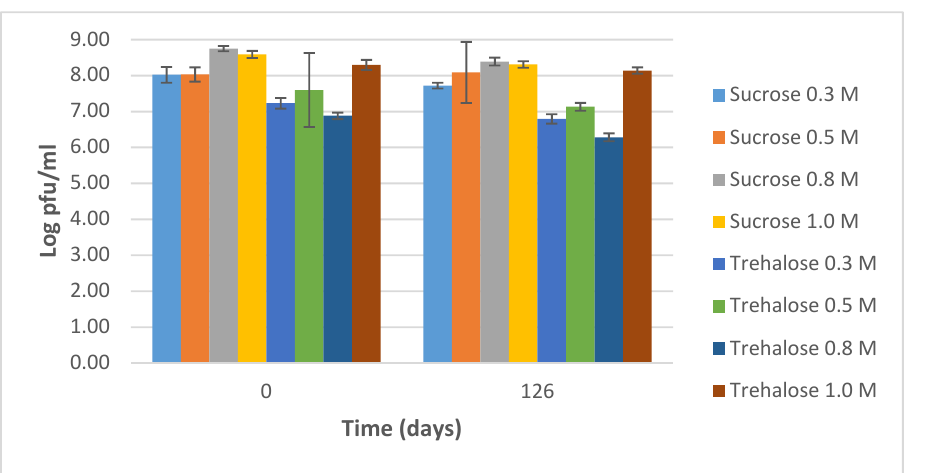
Figure 3. Stability of the infectivity of phage ISP, lyophilized at 9 log pfu/mL in two different stabilizers (sucrose and trehalose) at four different concentrations (0.3, 0.5, 0.8 and 1.0 M), after resuspension in saline and storage at 4 °C for 126 days. The results are the mean values of three titrations. Standard deviations are indicated.